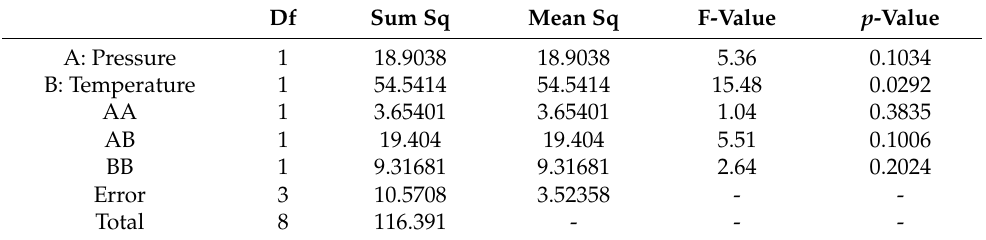
Figure 5. Standardized Pareto chart of the ( a ) total ketoprofen loadings in PLA filaments and ( b ) percentage of superficial ketoprofen with respect to the total amount impregnated.